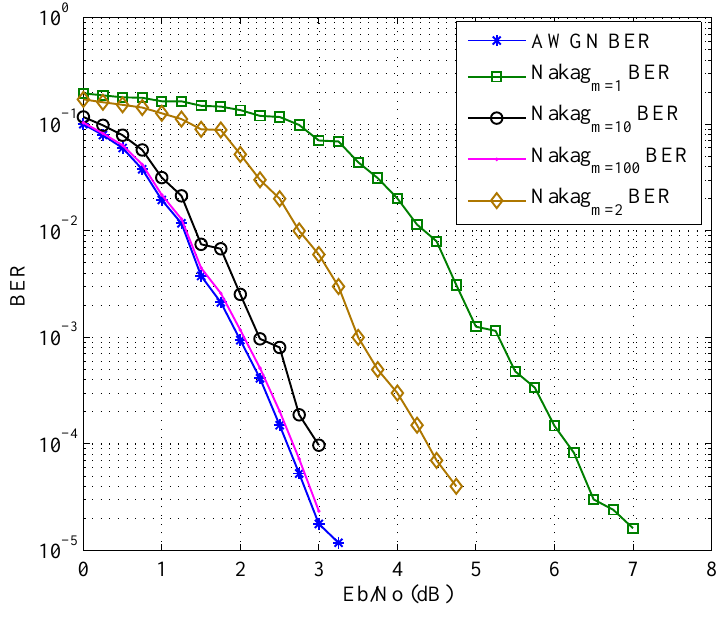
Figure 11. Energy efficiency for different targeted probability of bit error p